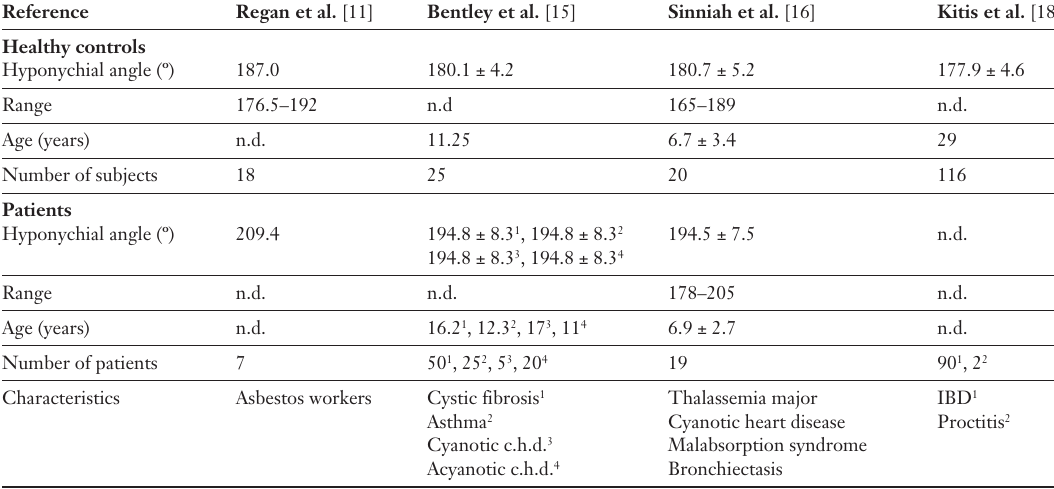
Table 1 Summary of histori- cal studies investigat- ing hyponychial an- gles for assessment of digital